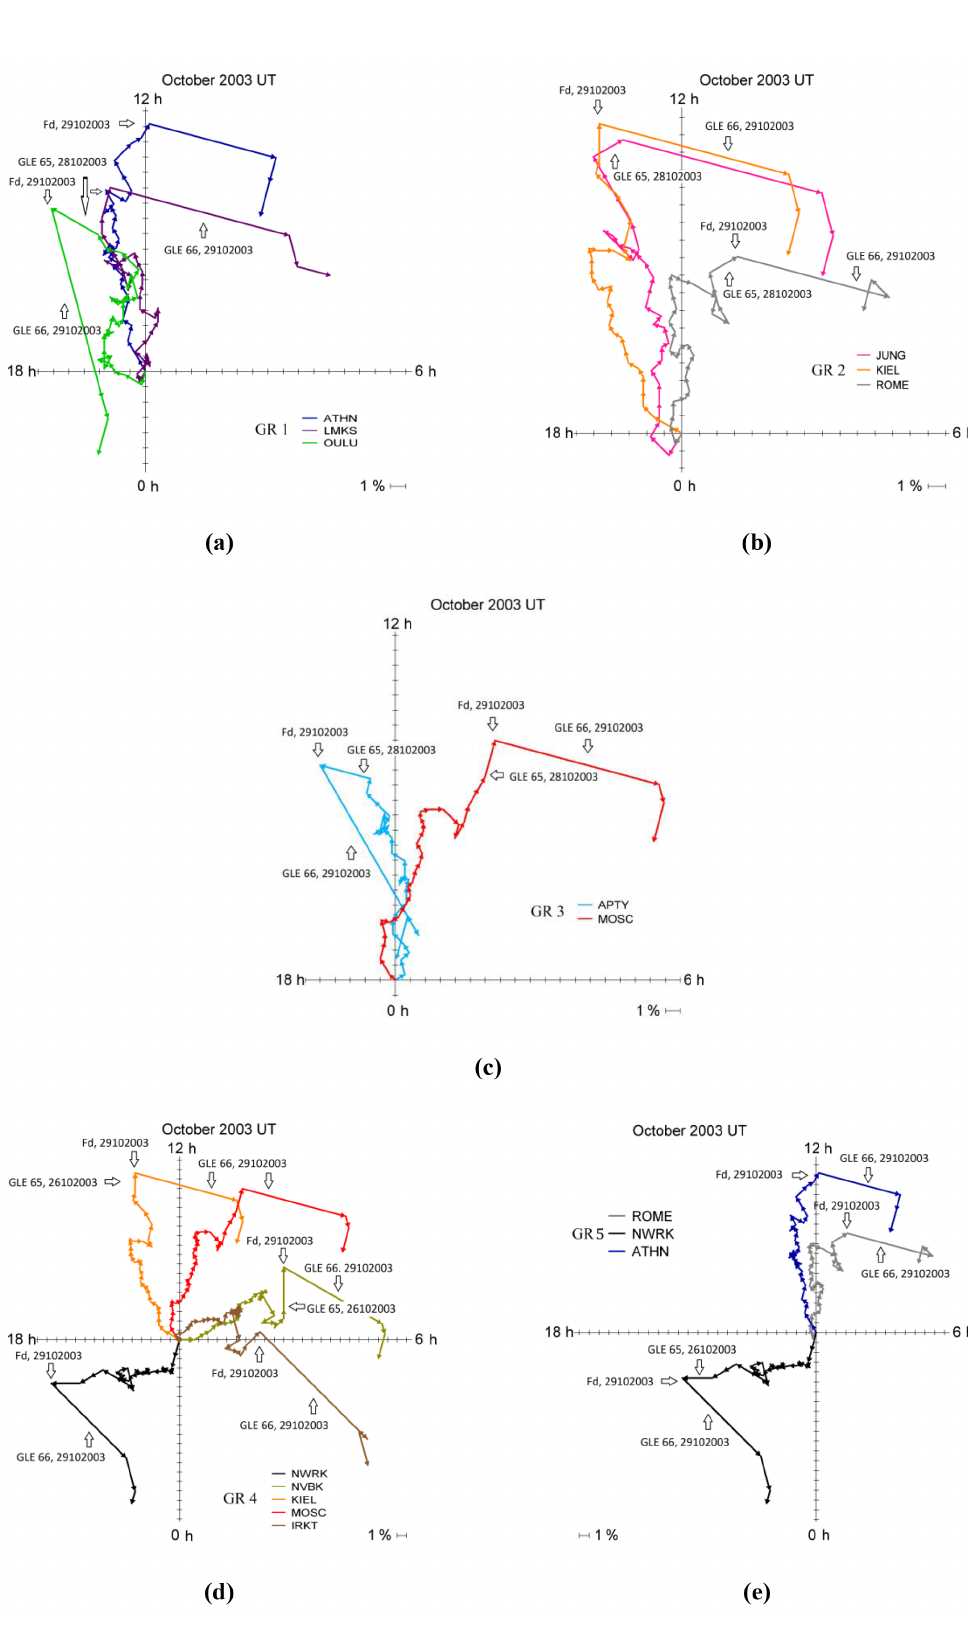
Figure 8. Daily diurnal vectors for all the groups of the stations for the month October